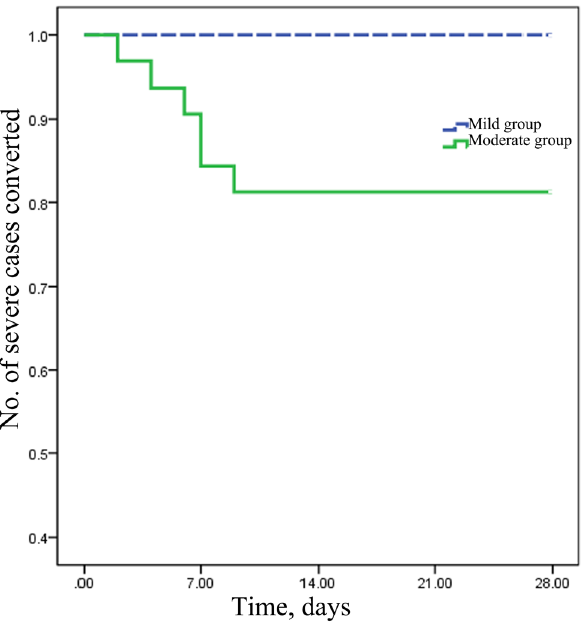
Figure 3. Kaplan–Meier survival analysis demonstrated increased severe case conversion in the moderate group (p < 0.043 by the log-rank test).